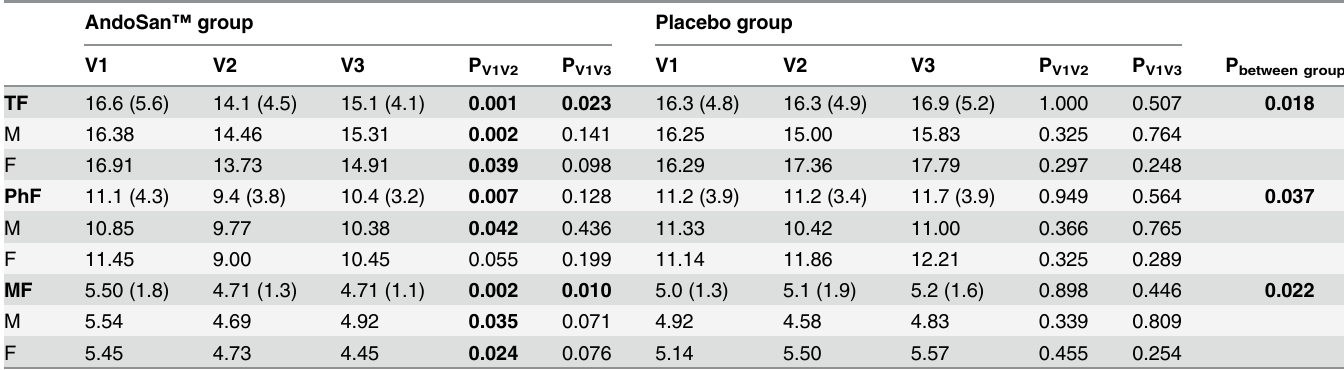
Table 4. Fatigue scores for the patients with (n = 24 AndoSan ™ and n = 26 placebo) UC. AndoSan ™ group Placebo